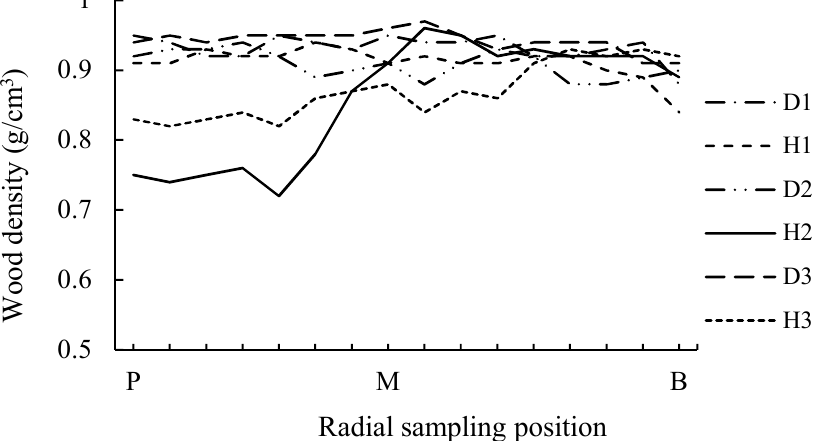
Figure 2. Wood density of declined (D1–D3) and healthy trees (H1–H3) of Quercus brantii in three areas of the Iranian forest: Dareh shahr, Sheshdar and Chavar. Density was measured in the wood samples from near-pith towards near-bark. H: Healthy trees; D: Declined trees; 1: Area A; 2: Area B; 3: Area C; P: Near-pith; M: Middle; B: Near-bark) .